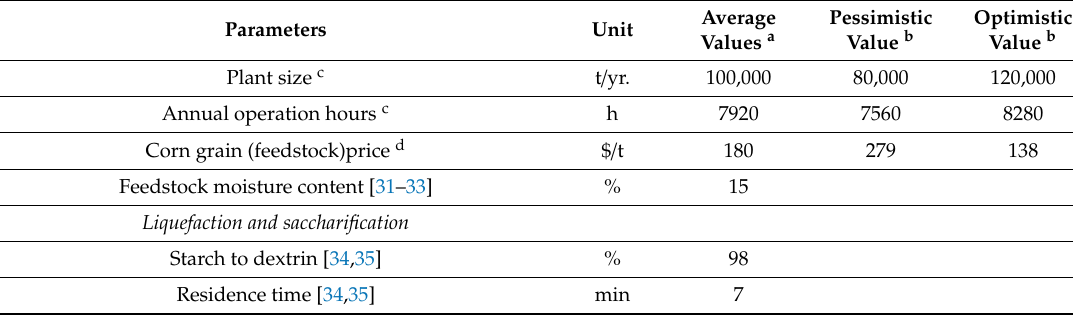
Table 1. Technical parameters required to estimate the lactic acid production cost, and their range required for sensitivity